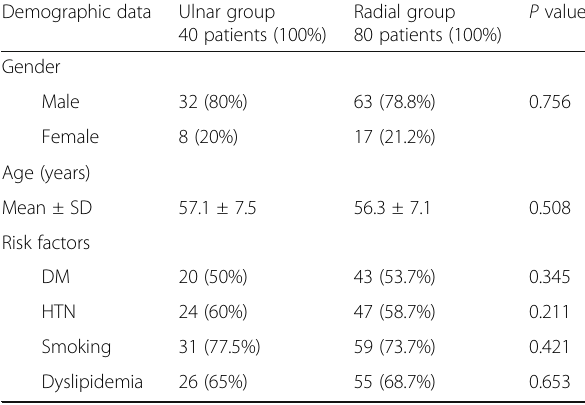
Table 1 Demographic data of the whole study population